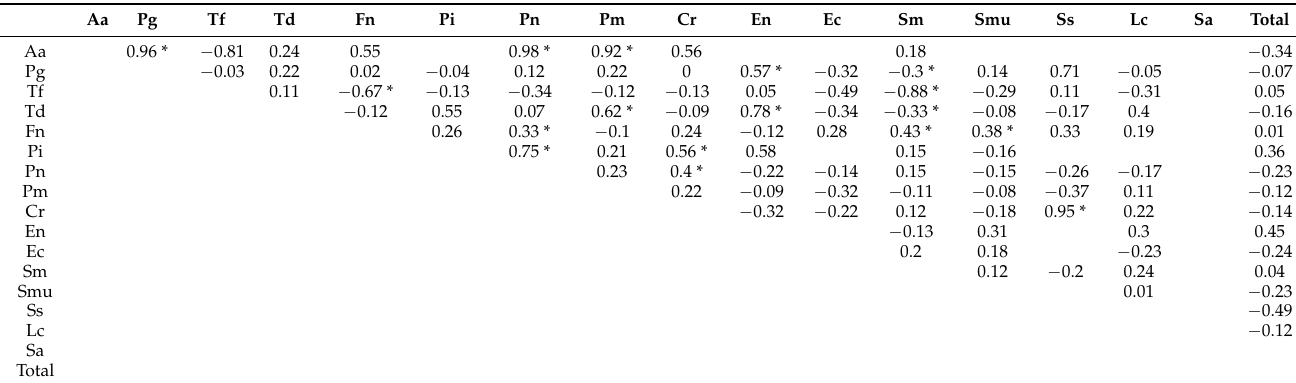
Table 6. Interspecies correlations in subjects with severe